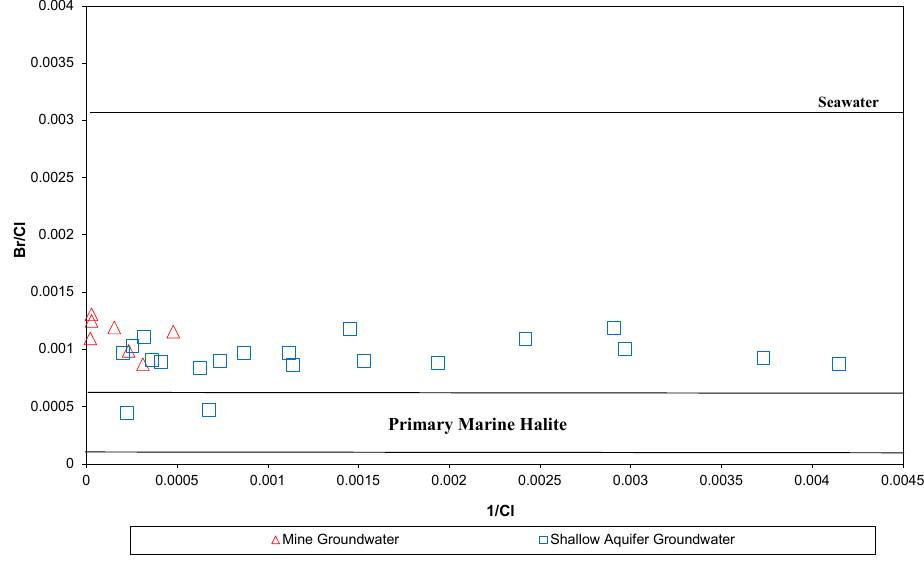
Figure 6. Plot of Br − /Cl − (meq/meq) versus 1/Cl − of shallow aquifer and mine groundwater. Like sodium, lithium can be considered a relatively well conserved element in solution: it is highly soluble and independent of Ph/oxidation conditions [25]. It does not precipitate in any mineral phase and is not controlled by any biological process. However, it is retained by clay minerals and can even be exchanged with sodium and potassium if the temperature is sufficient to release it from the matrix [26,27]. Its concentration also depends on rock- water interactions and has been used by [28] as an indicator of groundwater residence time. In this case, in contrast to the Br − /Cl − and Na + /Cl − ratios, the Li + /Cl − ratio of shallow aquifer groundwater decreases with increasing Cl − concentration (Figure 7). On the other hand, Li + /Cl − in mine water increases with salinity, like Br − /Cl − and Na + /Cl − . In addition, the high Li + /Cl − ratio in mine groundwater indicates that the origin of the salinity is in the aqueous